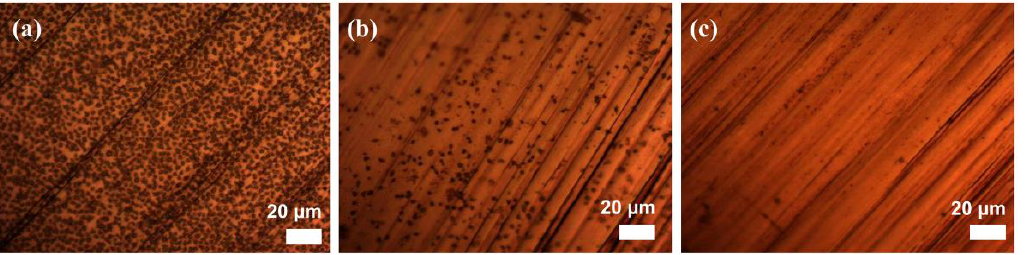
Figure 6. Platelet adhesion images acquired under different amplification times observed under op- tical microscopy for ( a ) ordinary iron, ( b ) structured iron and ( c ) superhydrophobic iron.